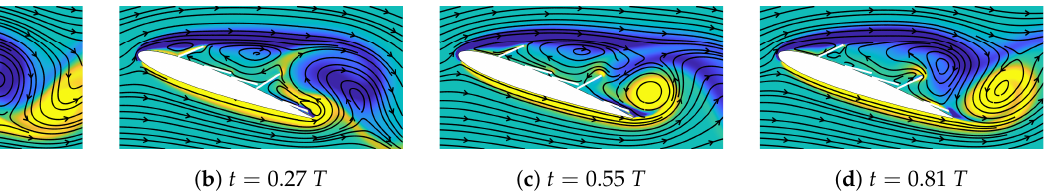
Figure 4. Vorticity contours at different time instants in one period of a lift cycle for the case of k β = 0.001 and i β = 0.001.